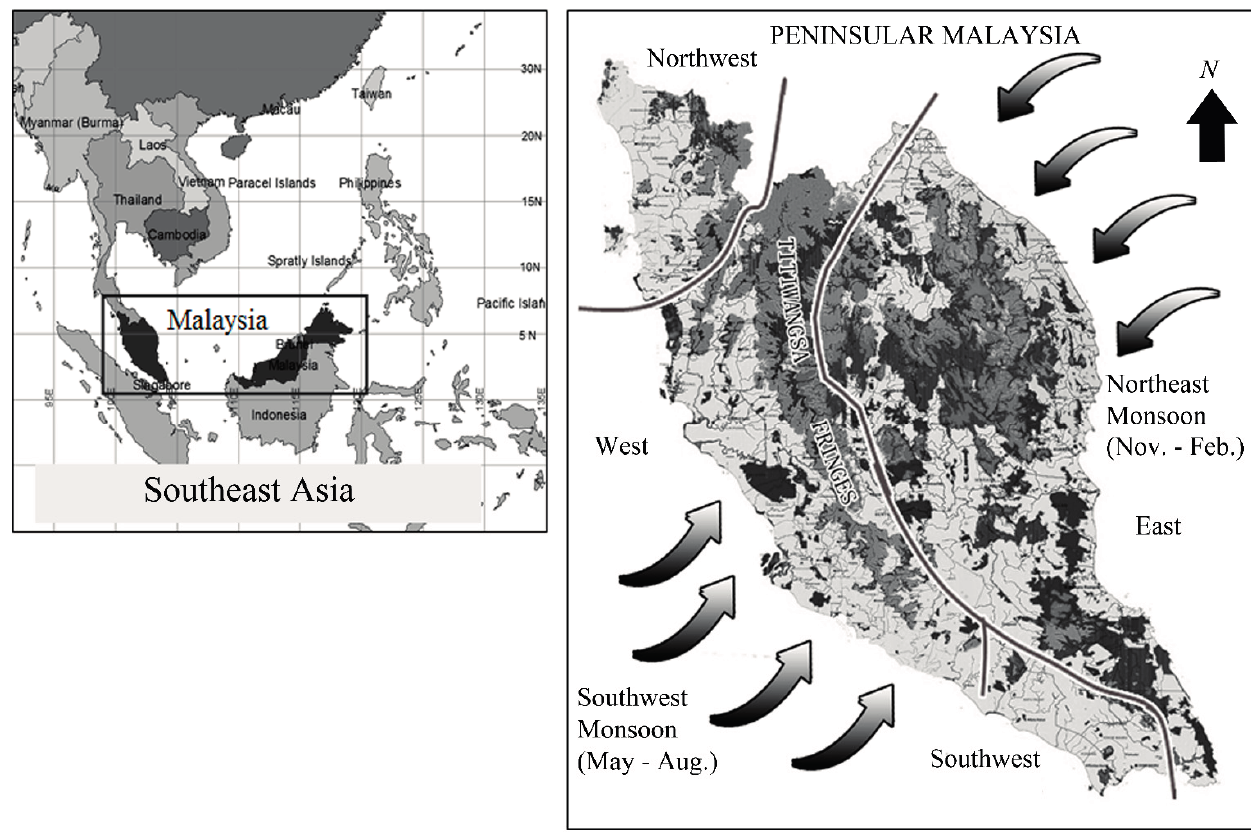
Figure 1. The study